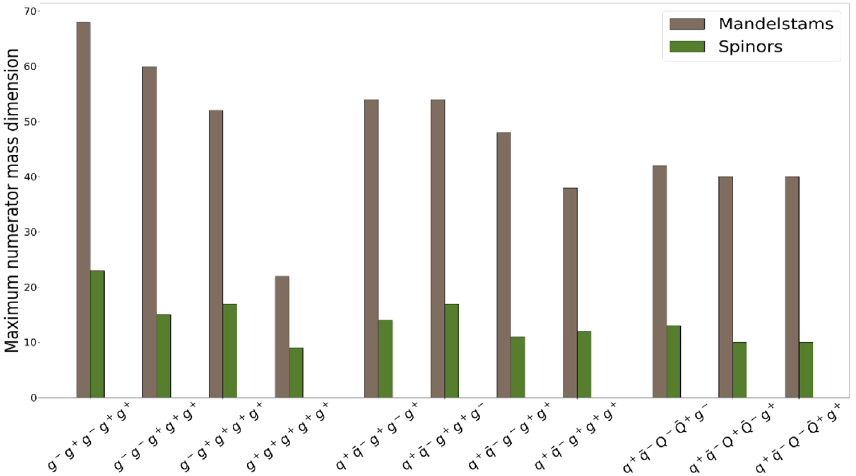
Figure 2 . Maximum mass dimension of numerator antäze to be reconstructed for each helicity configuration when using Mandelstam invariants or spinor